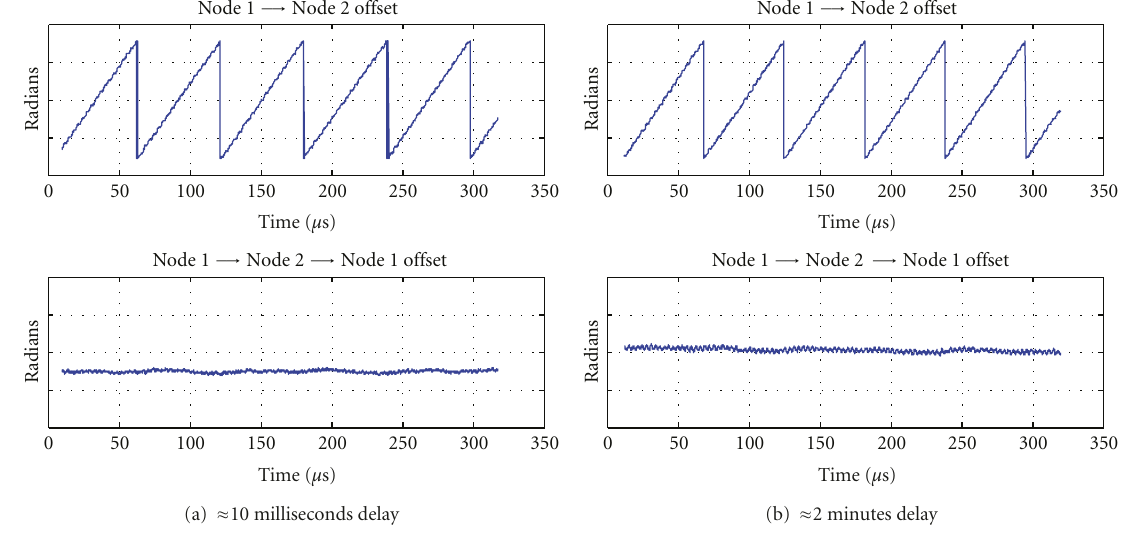
Figure 4: Experimental observation of carrier o ff set in a relay system.